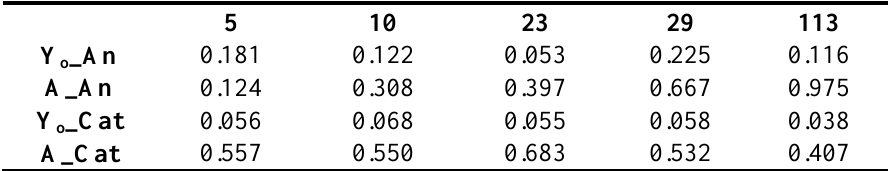
Table 2. EDL factors calculated via ECM for data taken over 113